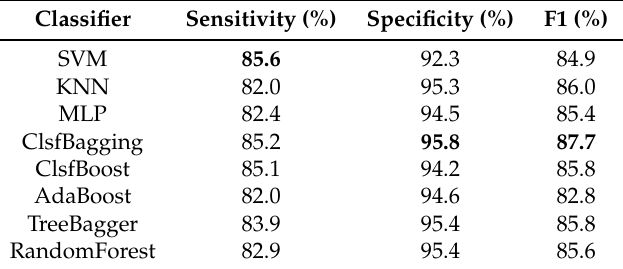
Table 3. Performance of classifiers in patient dependent models using the original imbalanced dataset and equal cost of misclassification (Results show average performance of all seven participants). The bold values show the highest performance among all the classifiers.